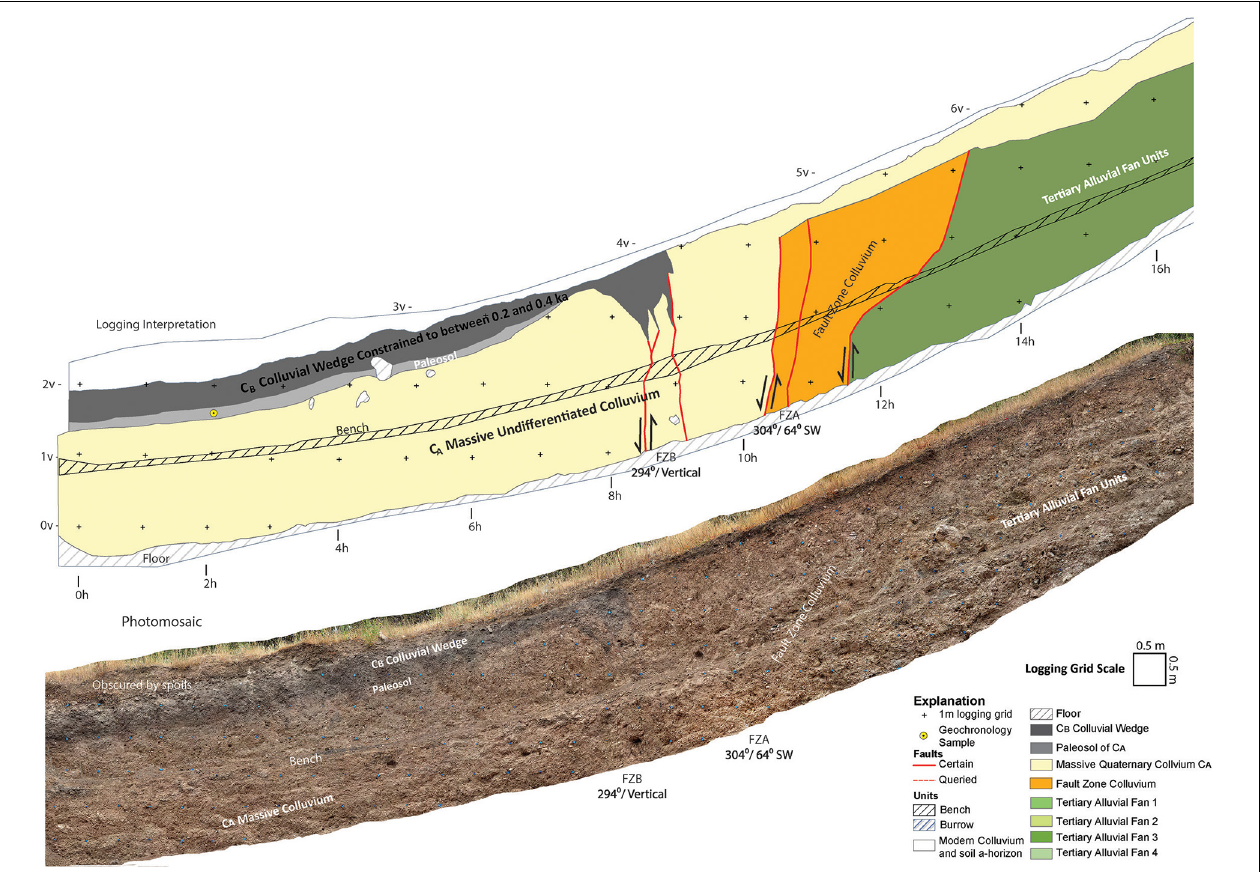
FIGURE 6 | Trench One South (T1S) west wall. Paleoseismic logging interpretation and photomosaic. The most recent event in T1S occurred along fault zone B (FZB) forming the C B colluvial wedge. This event is constrained to between 0.2 and 0.4 ka by samples TR25 and TR28 ( Figures 5 , 7 , 8 and Table 2 ). The C B colluvial wedge has been significantly modified by erosion on this trench wall. The filled fissure, providing evidence of a prior event ( Figure 5 ), is not present on this trench wall. The older C A colluvium is massive and was undifferentiable. We expect it is colluvium derived from recurrent motion along FZA, but we could not identify evidence to constrain events along this fault